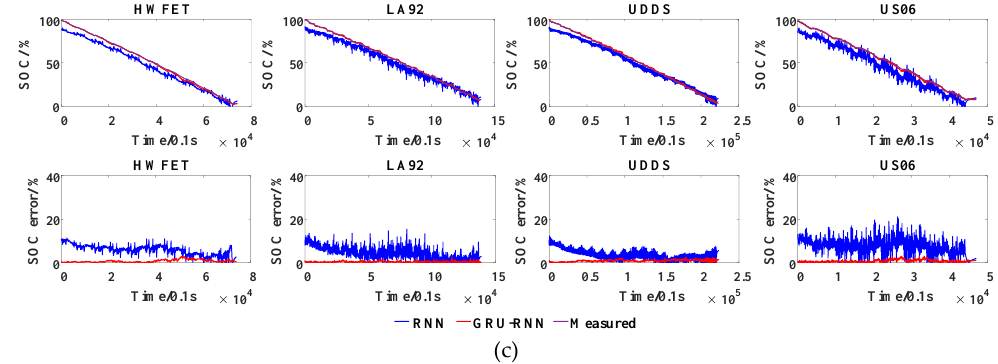
Figure 14. Performance comparison of the recurrent neural network (RNN) and the GRU-RNN: ( a ) 0 °C; ( b ) 10 °C; ( c ) 25 °C. Table 4. Quantitative comparison of the RNN and the GRU-RNN.